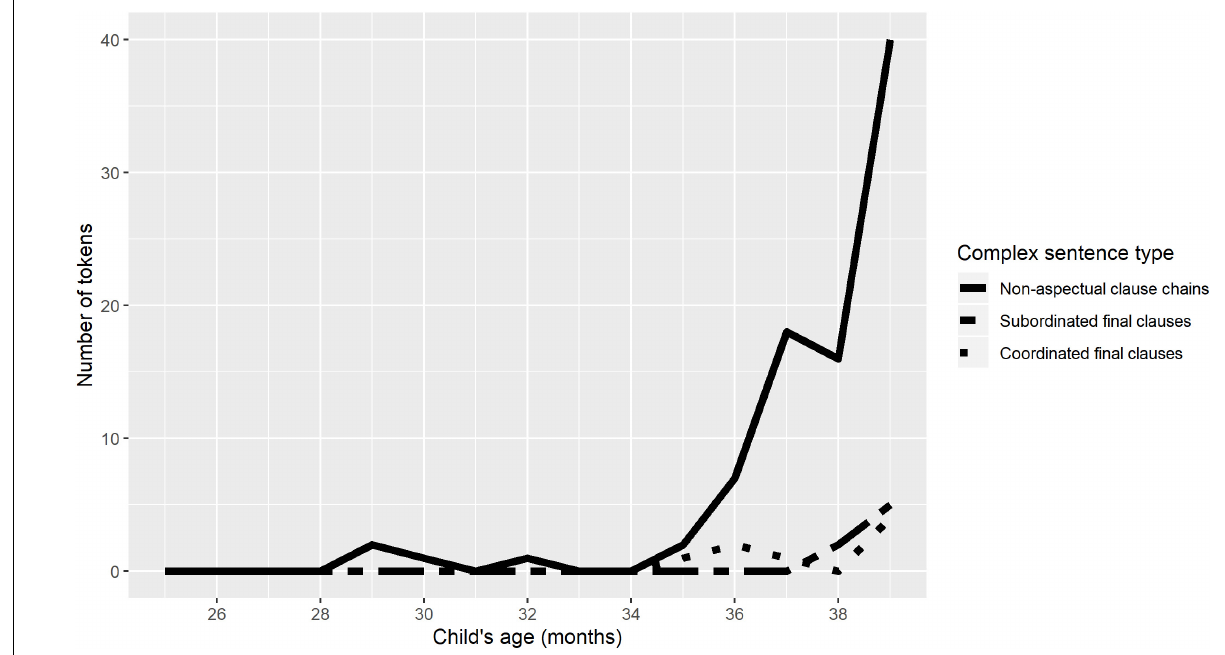
FIGURE 6 | Comparison of complex sentence types, TO.